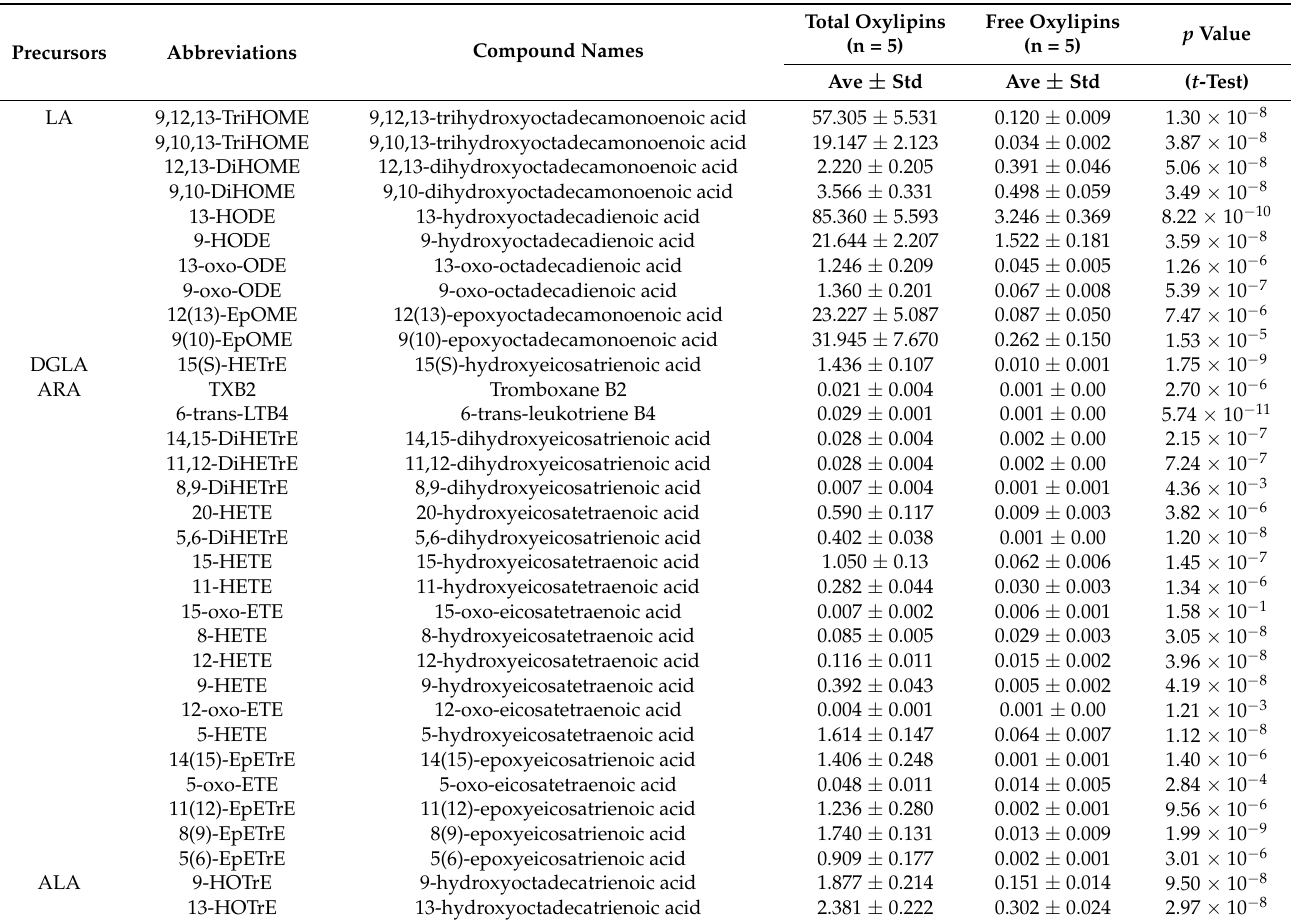
Table 4. Total (i.e., free + esterified) and free oxylipin concentration, nmol/g in sample 1. The samples were analyzed in triplicates and an unpaired t -test (two-tailed, two-sample equal variance (homoscedastic)) was used to compare the total versus free oxylipins. Fatty acid amount per lipid fraction